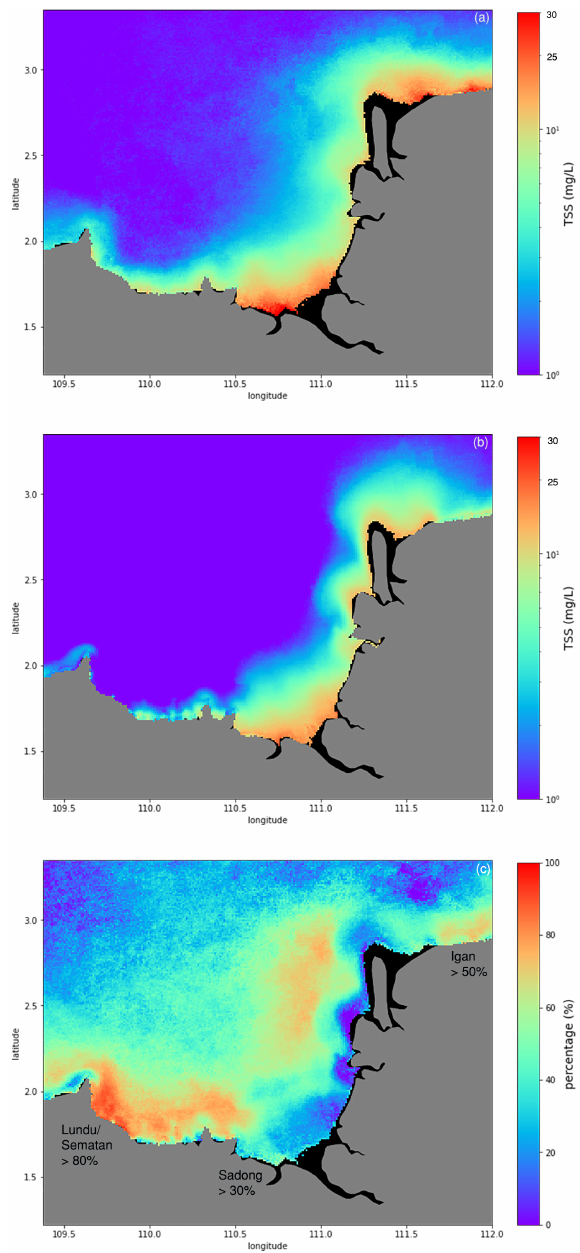
Figure 6. Long-term average of TSS estimates (mgL − 1 ) during the northeast monsoon (a) , and the southwest monsoon (b) . A map of the TSS difference between the northeast and southwest mon- soon periods, computed as a relative percentage (%), is shown in panel (c)